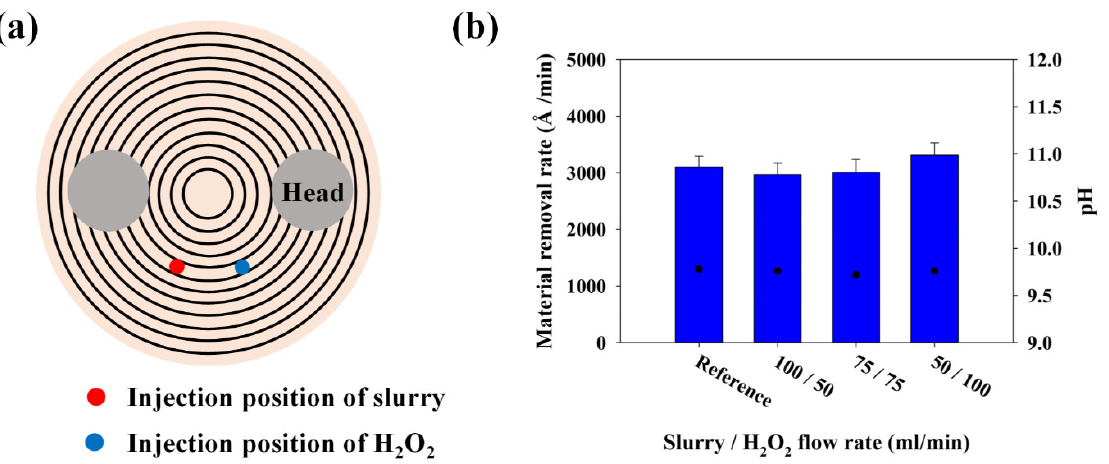
Figure 2. ( a ) Position of the two way injection;slurry–H 2 O 2 ( b ) MRR of the reference and the two-way injection with position; slurry–H 2 O 2 .